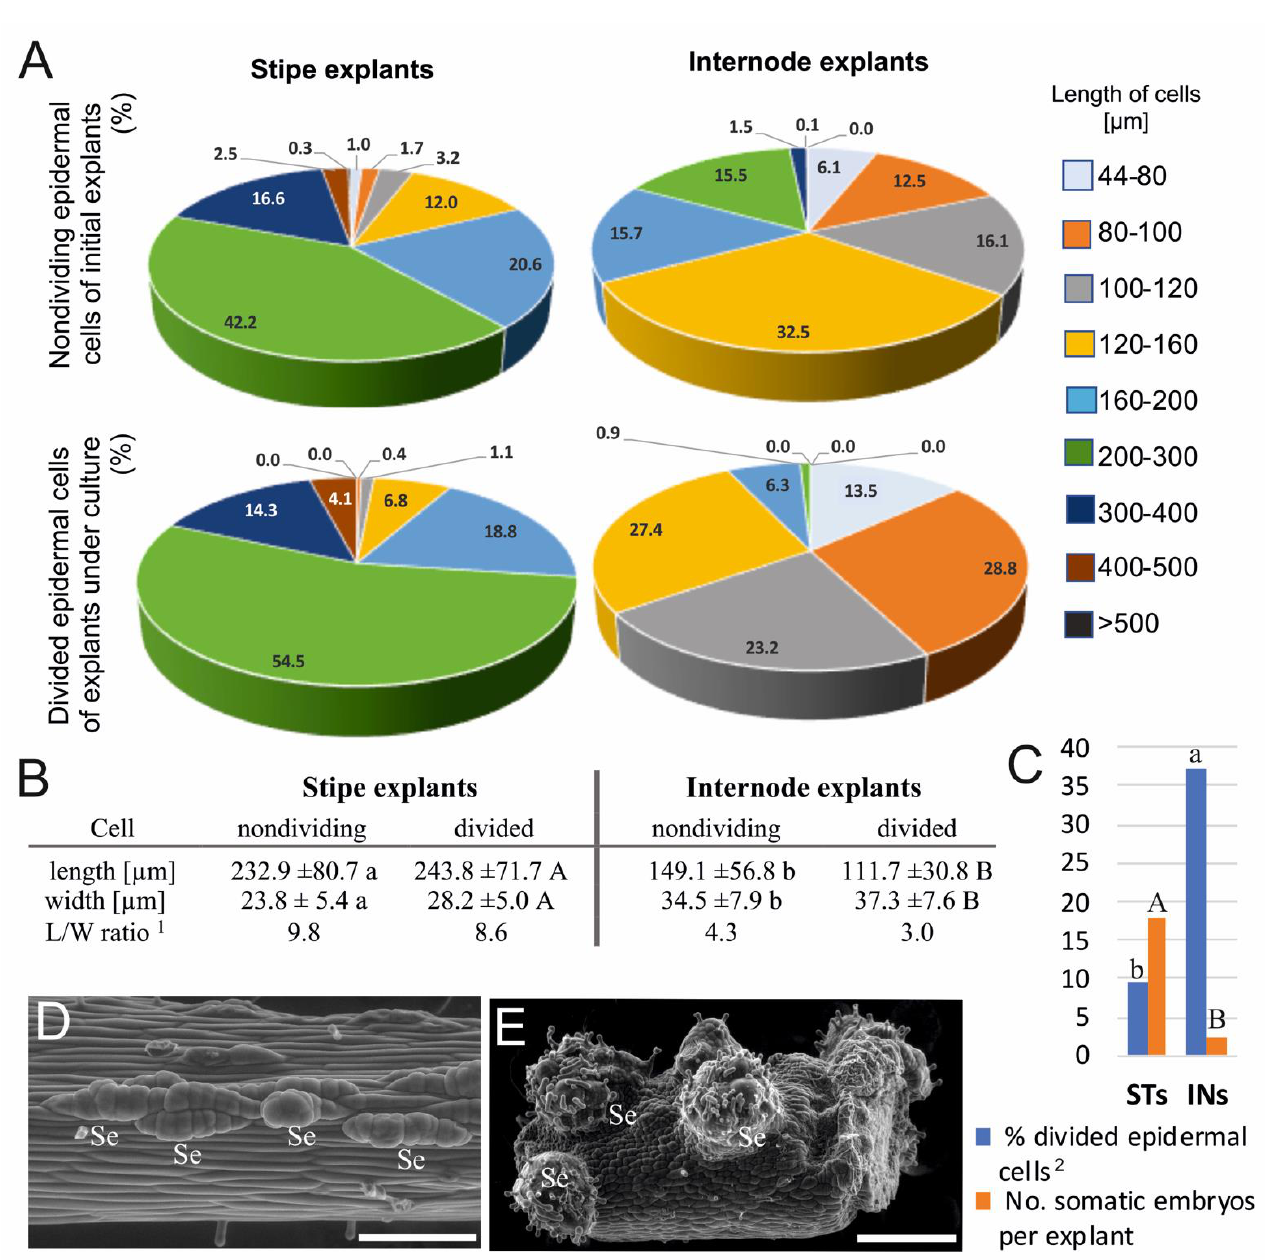
Figure 2. Comparison of biometrical features of epidermal cells, their capacity for division, and the somatic embryo production on stipe and internode explants. ( A ) Percentages of cells in relation to their length. ( B ) Average cell length and width: nondividing epidermal cells of initial explants; divided epidermal cells of explants under culture. ( C ) The ability of the explant cells to divide and produce somatic embryos. ( D , E ) Scanning electron microscope images of somatic embryos developed from the single epidermal cells of the stipe explant ( D ) and from multiple adjacent cells of internode explant ( E ). More details about the somatic embryo development were provided by Grzyb and Mikuła [4]. Abbreviations: INs, internode explants; Se, somatic embryo; STs, stipe explants. Scale bars: ( D ) 200 µm; ( E ) 500 µm. 1 L/W ratio was calculated as an average ratio between length and width for each cell. 2 Percentage of divided epidermal cells in relation to all cells of epidermis determined at 14th (stipes) and 6th (internodes) day of culture. The Student’s t -test was used to indicate statistical differences between the control explants of the STs and INs (lowercase letters), and between divided cells of both cultured explants (uppercase letters). Data followed by different letters were significantly different at p < 0.05.